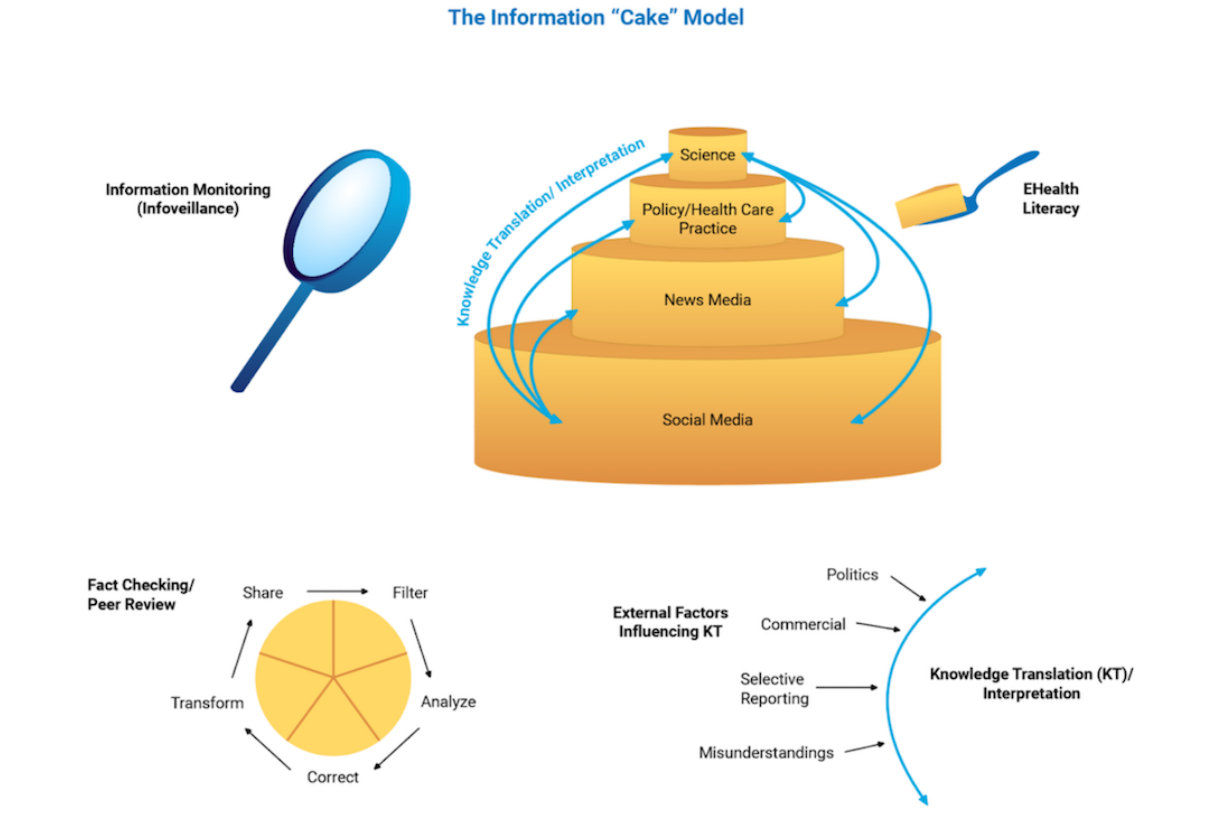
Figure 1. The Information “Cake” Model. The four pillars of infodemic management are information monitoring (infoveillance; top left); building eHealth Literacy and science literacy (top right); encouraging knowledge refinement and quality improvement processes for information providers, such as fact checking and peer review (bottom left); and Knowledge Translation, meaning to translate knowledge from one layer to another, while minimizing distorting factors (bottom right). eHealth: electronic health; KT: knowledge